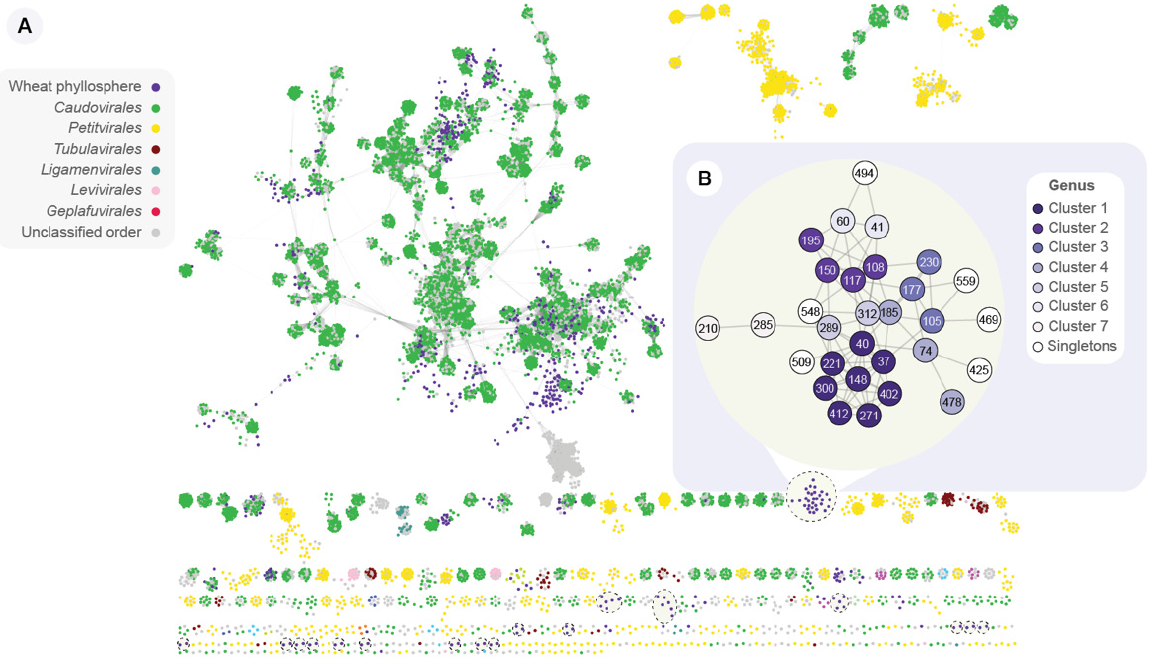
Figure 3. Protein sharing network of wheat phyllosphere vOTUs, viral RefSeq genomes, and IMG/VR viral sequences. ( A ) Overview of the vConTACT2 protein-profile network, depicting the taxonomic context of phylloviruses. In this network, nodes represent viral sequences, and edges connecting two nodes indicate a shared protein profile. RefSeq nodes are colored according to their taxonomy at the order level. Dashed-line circles indicate the 17 discrete groups of interconnected nodes containing only wheat phyllosphere vOTUs. ( B ) Zoom-in on the biggest group of interconnected nodes containing only wheat phyllosphere. Nodes are colored according to the assigned vConTACT2 viral cluster, which delineates clusters at approximately the genus level.